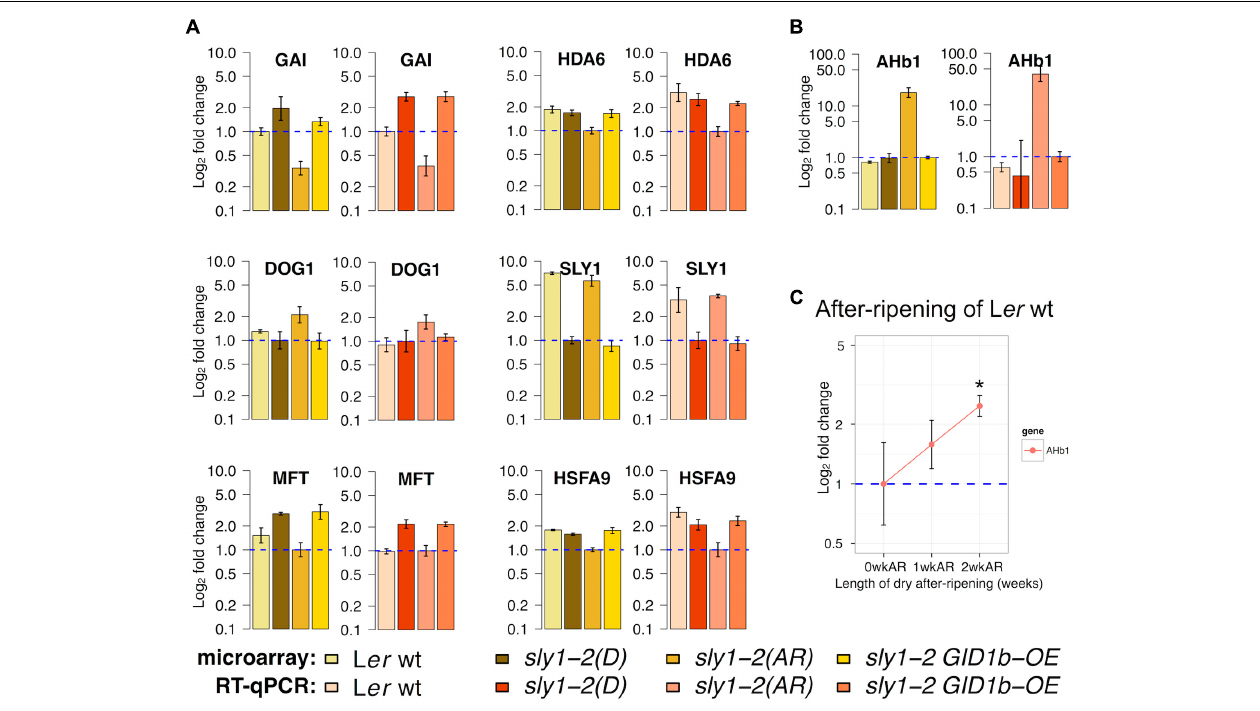
FIGURE 8 | Comparing RT-qPCR analyses of transcriptome differences with those measured by microarray. (A) Plots for a selection of genes with differential regulation in both ARvsD and DvsWT comparisons and (B) plots for AHb1 , the most AR-up-regulated gene in sly1-2 dry seeds. Both microarray (brown) and RT-qPCR (orange) relative expression are shown relative to the same calibrator, set to height of 1 and indicated by the blue dotted-line. For this comparison, RMA normalized microarray data was analyzed using the ddCT method relative to the same constitutively expressed AKR2B control gene used for analysis of RT-qPCR data. (C) L er wt was harvested “near maturity” and seeds were collected for RT-qPCR to examine transcript levels of AHb1 at 0, 1, and 2 weeks of after-ripening (0, 1, and 2wkAR). Asterisk indicates significance relative to 0wkAR ( p = 0.04). For all RT-qPCR experiments, statistical significance was determined by pairwise t -test with Bonferroni–Holm correction for multiple comparisons (see Supplementary Figure 4 for p -values). Error bars represent